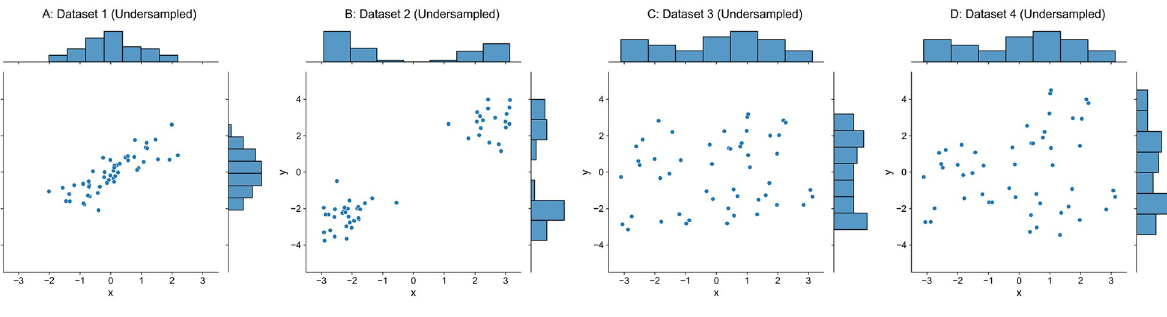
Fig 3. Undersampled